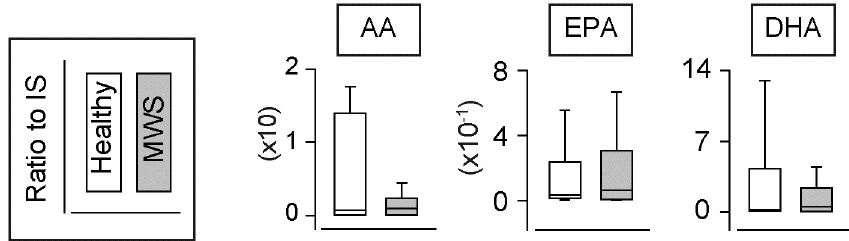
Fig 1. The urinary level of PUFAs. The urinary levels of arachidonic acid (AA), eicosapentaenoic acid (EPA) and docosahexaenoic acid (DHA) in healthy marmoset (N = 7) and marmosets with MWS (N = 7).